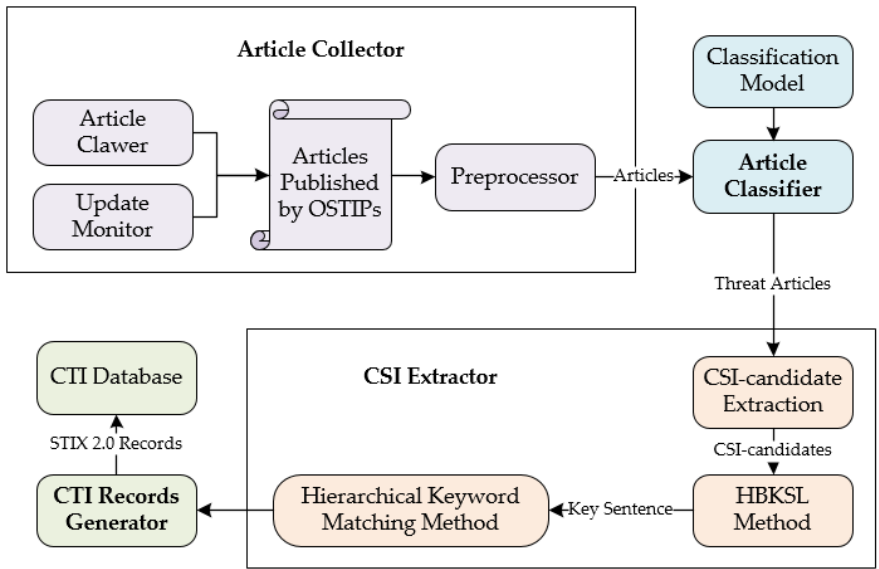
Figure 3. Architecture of the automatic approach to generate the cyber threat intelligence records based on multi-type OSTIPs (GCO).